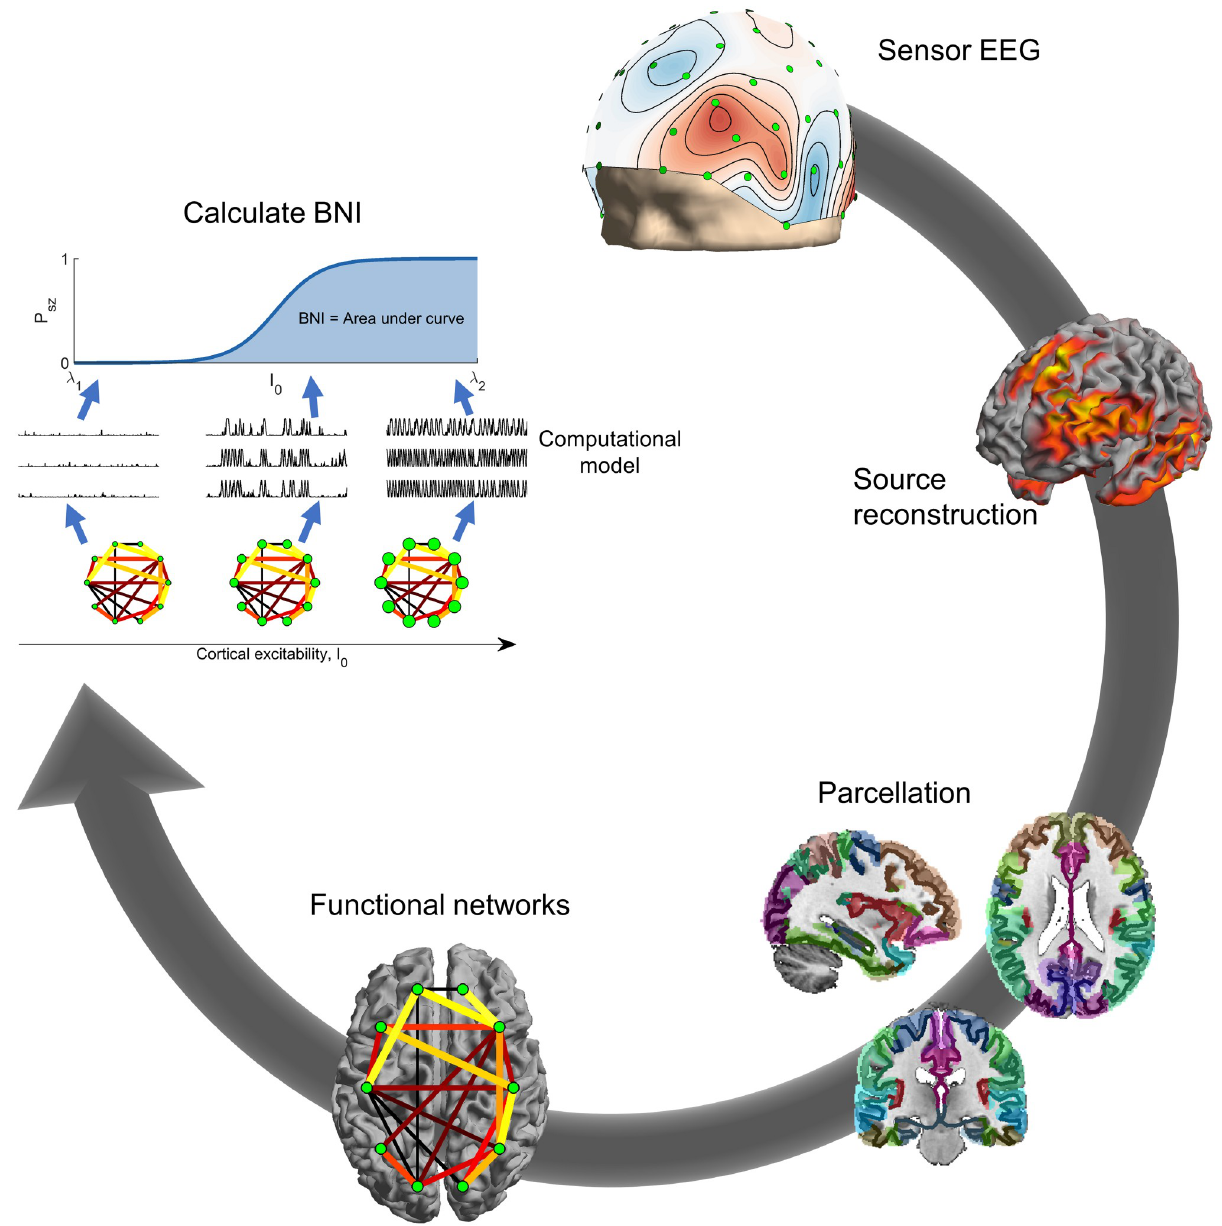
Fig 1. Calculation of BNI. Clockwise from top: Sensor EEG was source reconstructed using the eLORETA algorithm. The source solution was parcellated into 40 ROIs given by the Brainnetome atlas. Functional networks were calculated from the parcellated time courses of the 40 regions using theta-band phase locking factor. BNI was calculated by placing the network into a model of seizure transitions, and increasing the excitability of cortical tissue in the model. For each value of the excitability parameter I 0 (visualised by node size in the figure), the fraction of time spent in the seizure state by the simulated dynamics was calculated. BNI was the area under the curve of fraction of seizure time against I 0 .